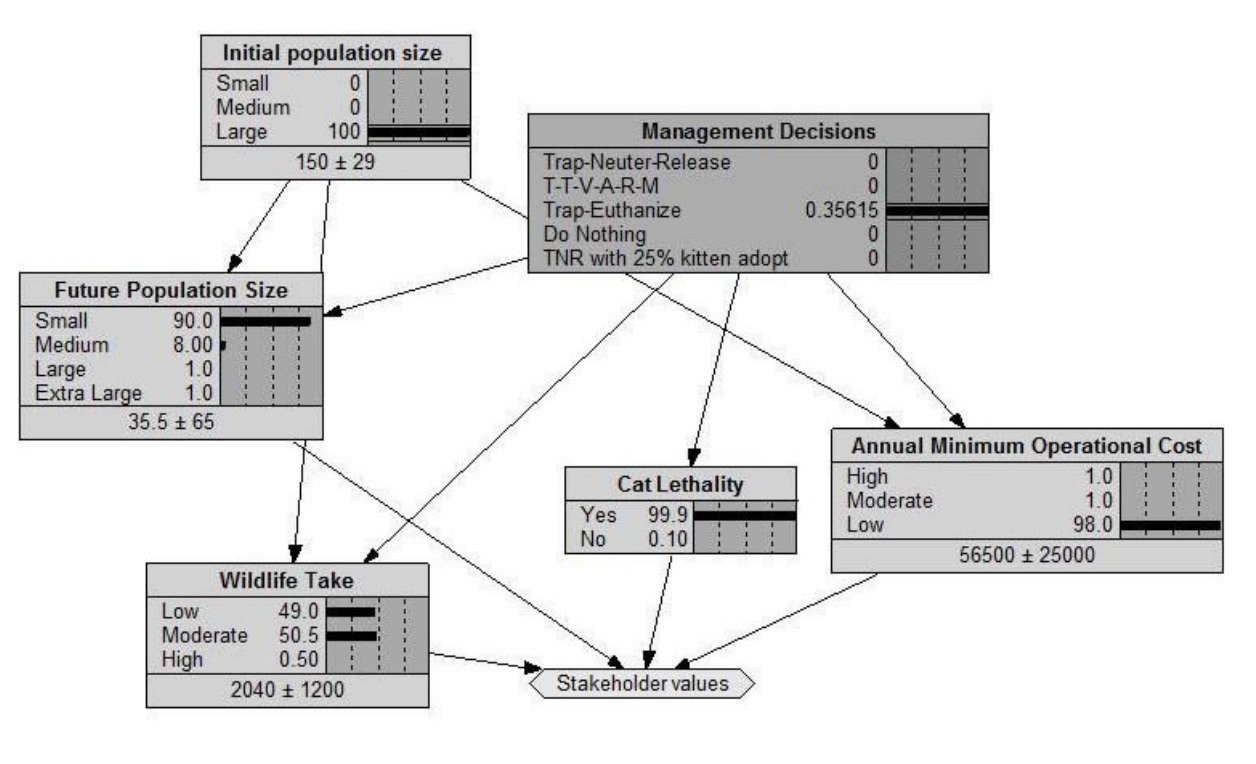
Fig. 8 . Prediction of future population size and wildlife take under TE